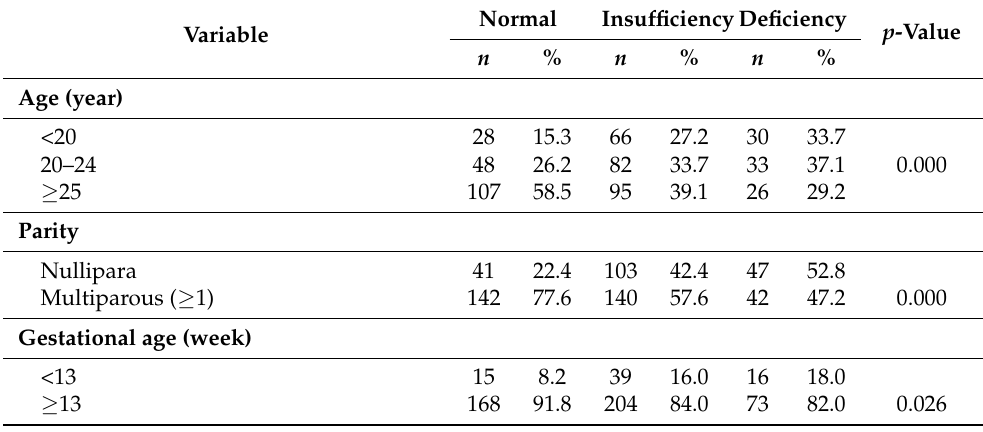
Table 3. Differences in the prevalence of vitamin D deficiency and insufficiency among pregnant rural women by various socio-demographic, dietary and pregnancy-related